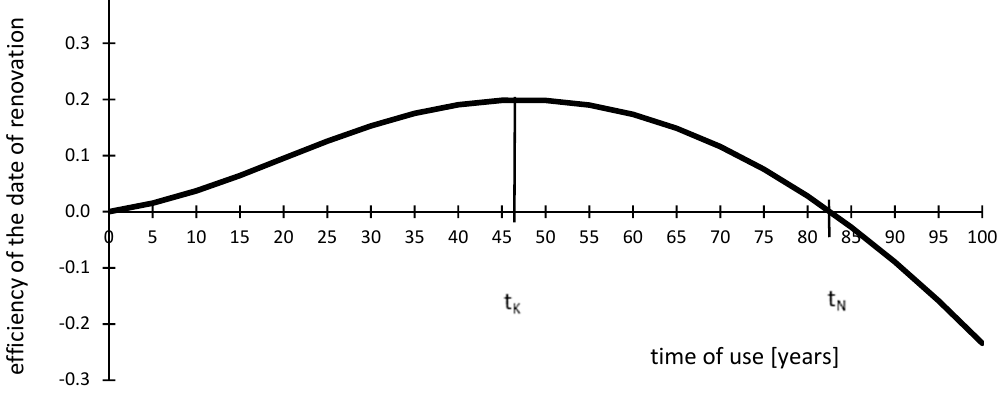
Figure 3. Function of the efficiency of renovation time K(t).